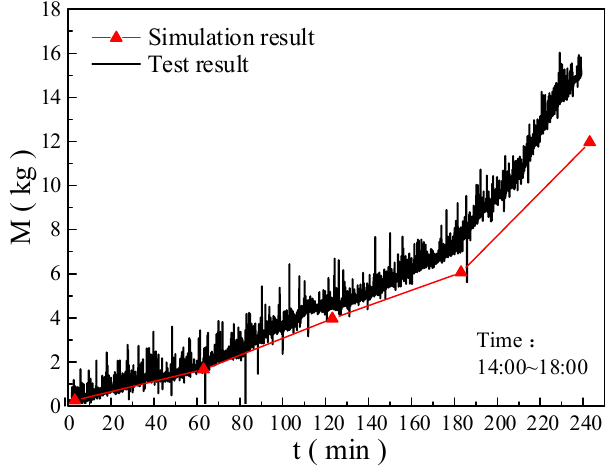
Figure 13. The icing mass of the whole insulator. Table 4. Comparison of icing mass.